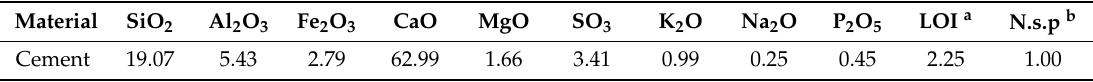
Table 1. Chemical composition of cement.